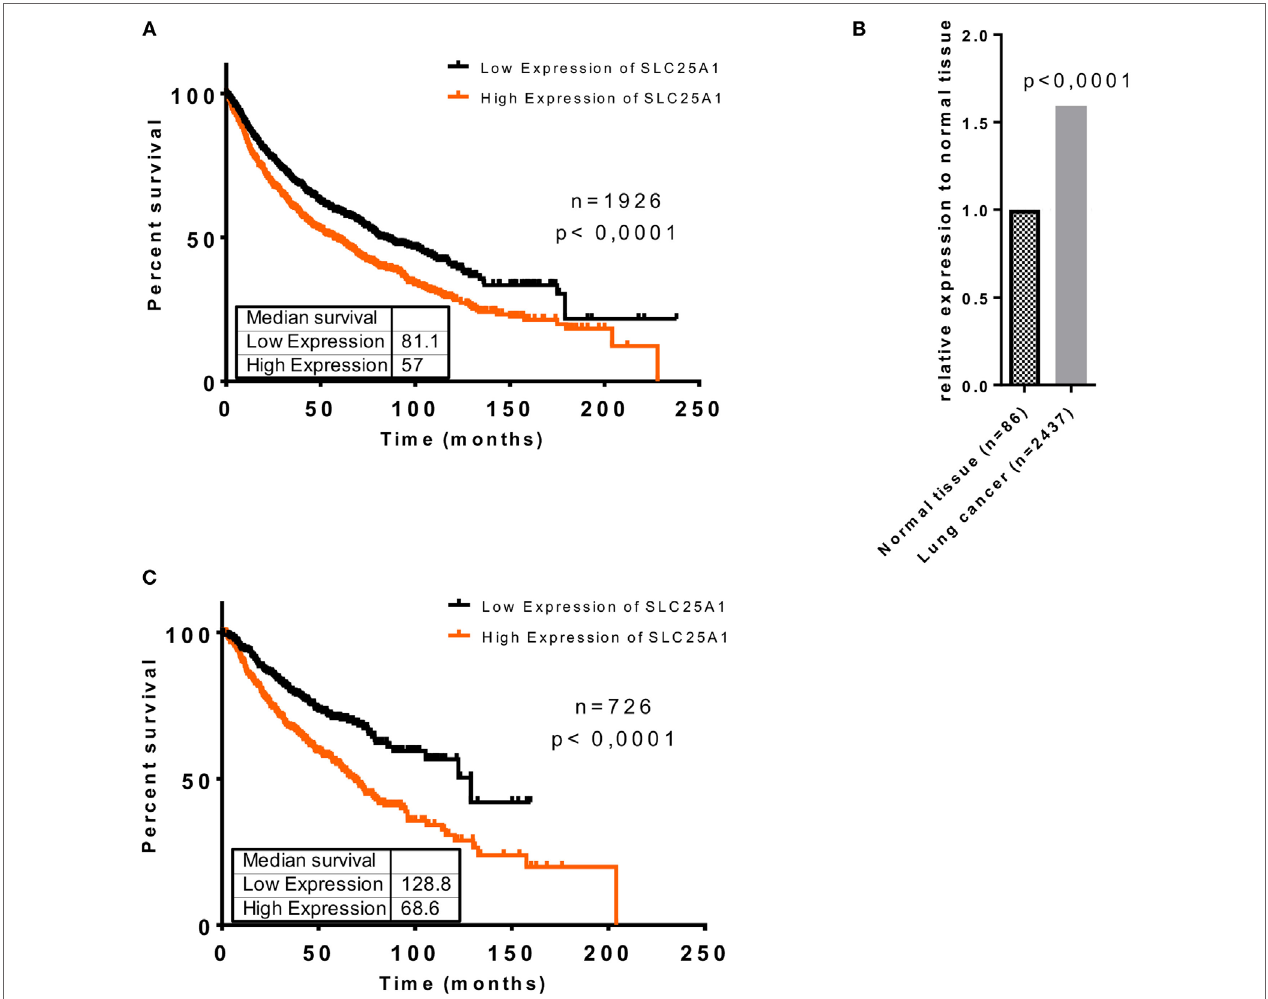
FigUre 2 | Elevated expression of SLC25A1 is associated with worse clinical outcome of lung cancer patients, particularly upon tumor resection with negative margins (R0). Clinical relevance of the SLC25A1 expression was obtained by searching and analyzing available patient array data by the Kaplan–Meier plotter tool (kmplot.com). Data show (a) overall survival in lung cancer patients, (B) relative expression of SLC25A1 in normal tissue and lung cancer, and (c) overall survival in lung cancer patients upon surgery with negative tumor margins (R0). For the analysis, the cohort was split by median of SLC25A1 expression (“High” and “Low,” respectively). Median survival (in months) is indicated for each survival